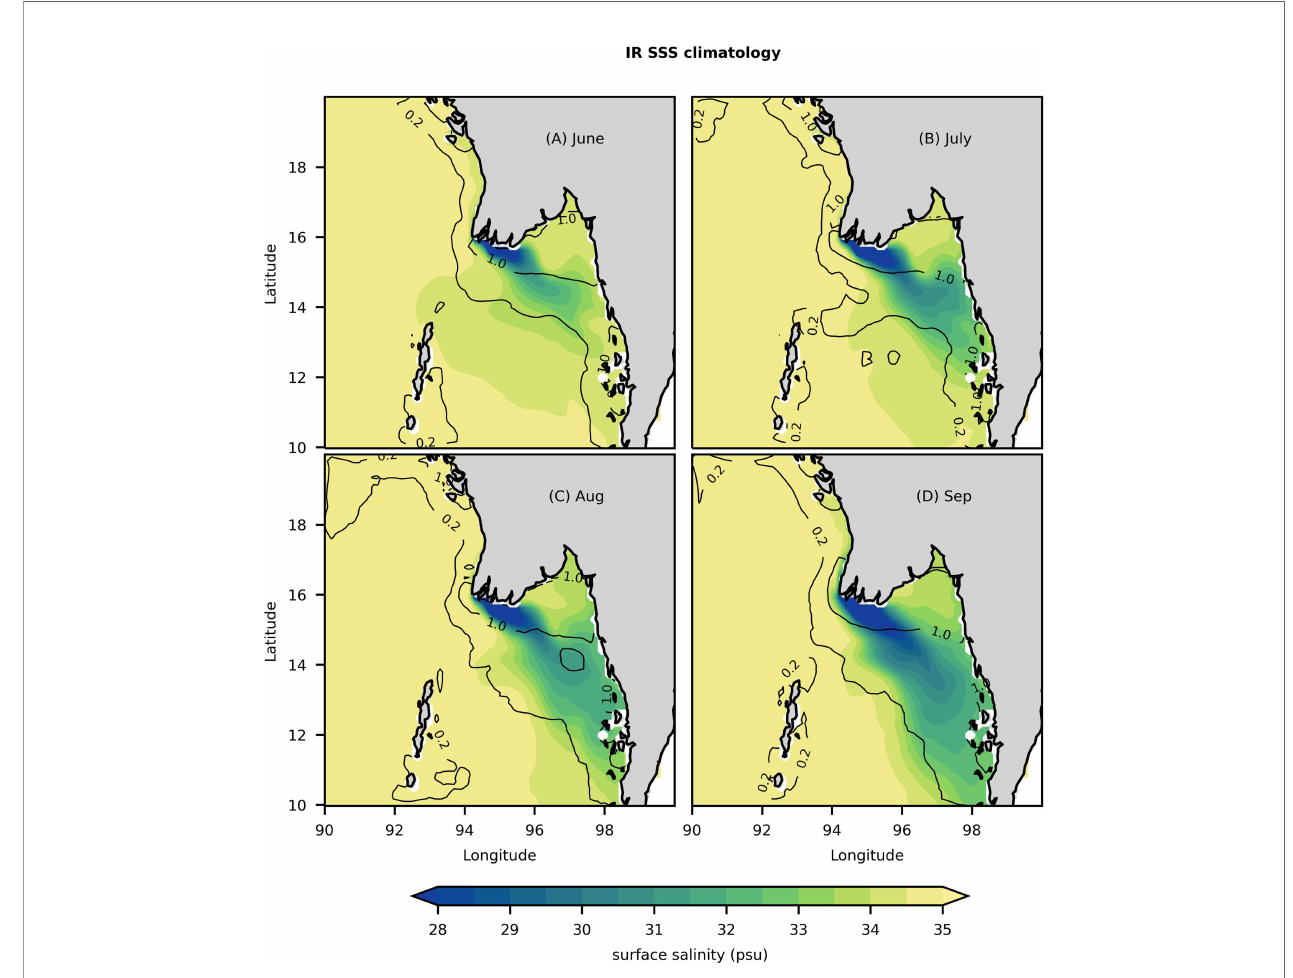
FIGURE 5 | Maps of sea surface salinity climatology (shading) obtained from experiment IRFullW and Chlorophyll-a climatology (black contours) obtained from MODIS for the months of summer monsoon. Units of Chlorophyll-a concentration are mgm -3 . MODIS data was interpolated to ROMS grid and smoothed using a 5 point boxcar smoother in both East-West and North-South directions before